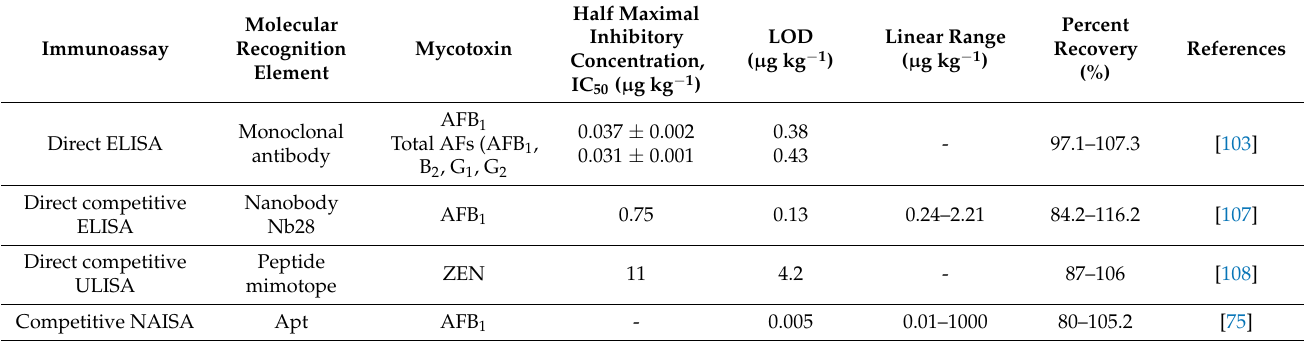
Table 4. Improvement of immunoassays in terms of molecular recognition elements on the basis of ELISA